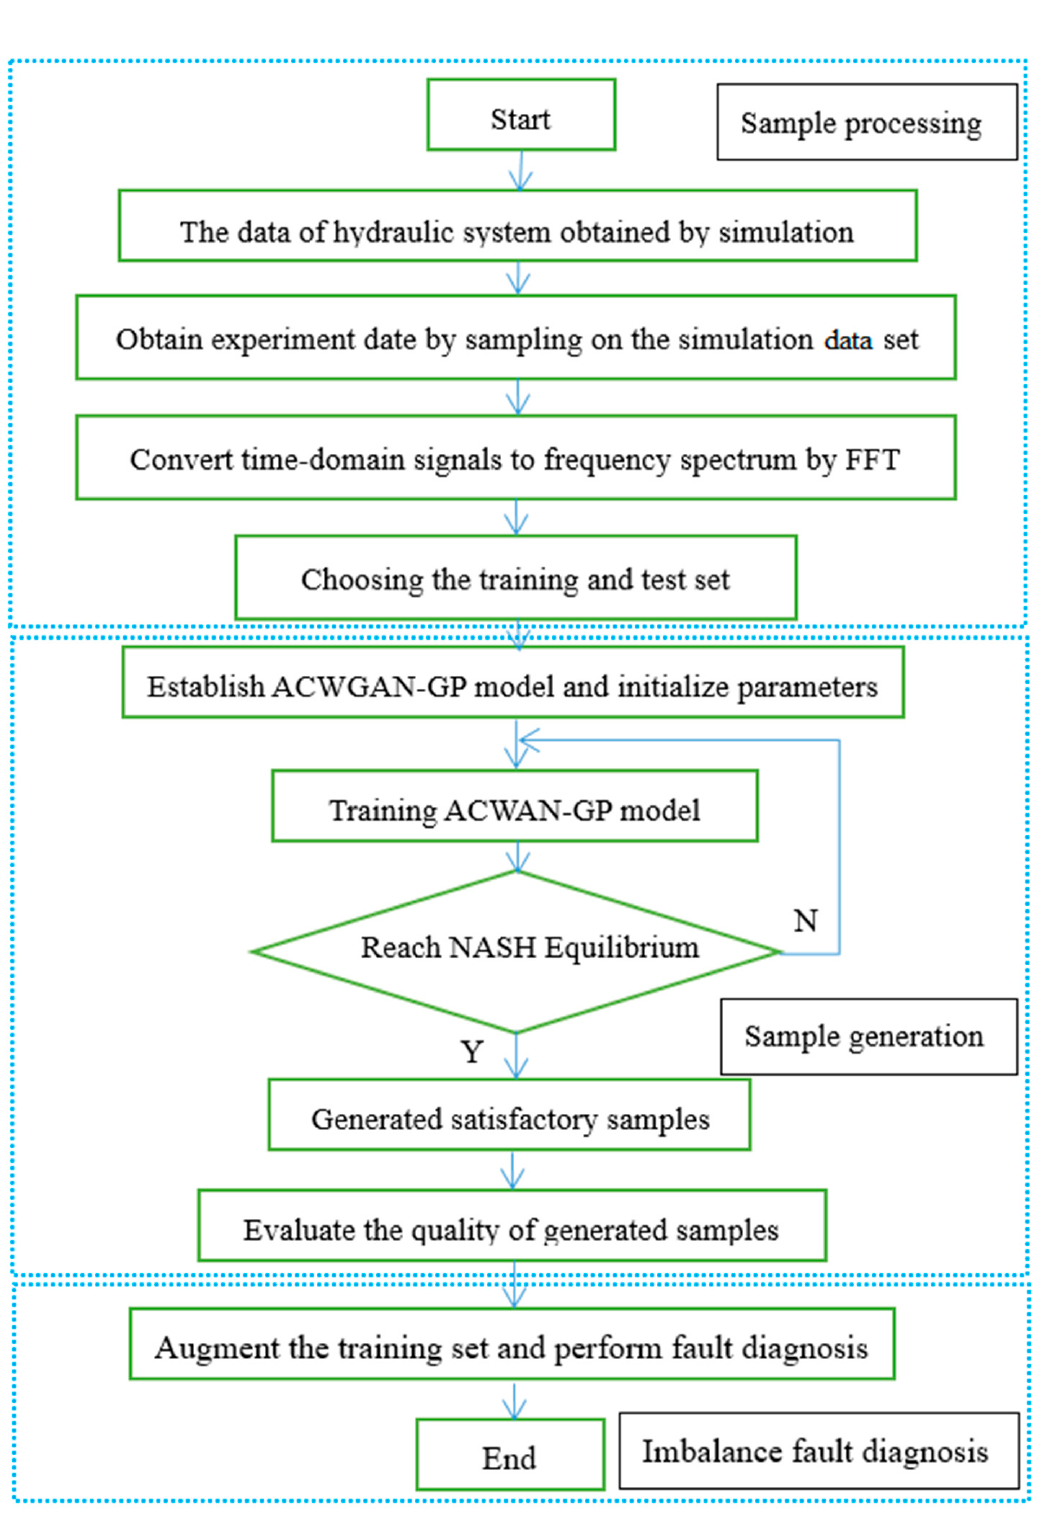
Figure 2. Flowchart of ACWGAN-GP. ACWGAN-gp is an improved GAN model to solve the data imbalance in the fault diagnosis of the aircraft hydraulic system. Specifically, ACWGAN-gp builds a new GAN model by introducing the Wasserstein distance and gradient penalty. The generator consists of a random noise vector Y and a sample vector X with a specific classifier. The new samples are generated through the generator. The new samples and real samples are